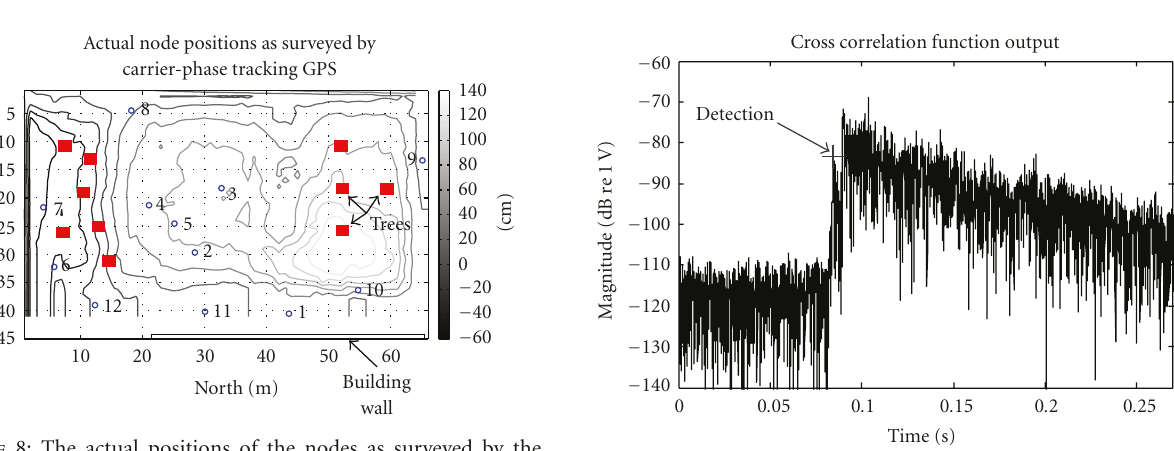
Figure 9: Typical matched filter